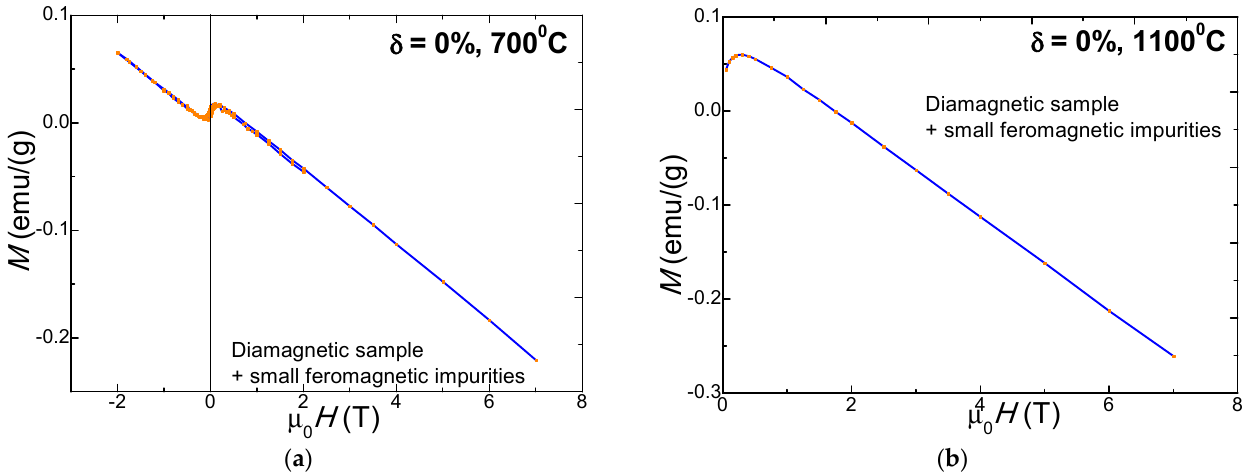
Figure 3. Diamagnetic properties of the SiO 2 matrix ( δ = 0%) for the samples calcined at 700 ◦ C ( a ) and 1100 ◦ C ( b ). The room temperature magnetic hysteresis loops, the saturation magnetization ( M S ), remanent magnetization ( M R ), coercive field ( H c ) values of (Zn 0.6 Mn 0.4 Fe 2 O 4 ) δ (SiO 2 ) 100 − δ ( δ = 25–100%) NPs calcined at 700 and 1100 ◦ C are shown in Figure 4. Typical ‘S’ shape hysteresis loops are obtained for all the investigated NPs, indicating their soft magnetic behavior. For the NPs calcined at low temperature (400 ◦ C), the magnetic parameters values are very small, making difficult to quantify the effect of the heat treatment on the sample magnetic properties. Contrarily, the hysteresis loops show saturation under the same magnetic field for the NPs calcined at 700 ◦ C and 1100 ◦ C. The calcination temperature greatly influences the morphology and the phase constitution of compounds [26]. The hysteresis loops indicate low coercivity ( Hc ) values suggesting that tization [16]. The H C of the spinel nano-ferrites is mainly dictated by the magnetocrystalline anisotropy, particle-particle interaction, strain, morphology and the grain sizes [27]. The M S , as well as the magnetic anisotropy of the NPs calcined at 700 and 1100 ◦ C, increase with increasing of the Zn 0.6 Mn 0.4 Fe 2 O 4 content in the SiO 2 matrix.